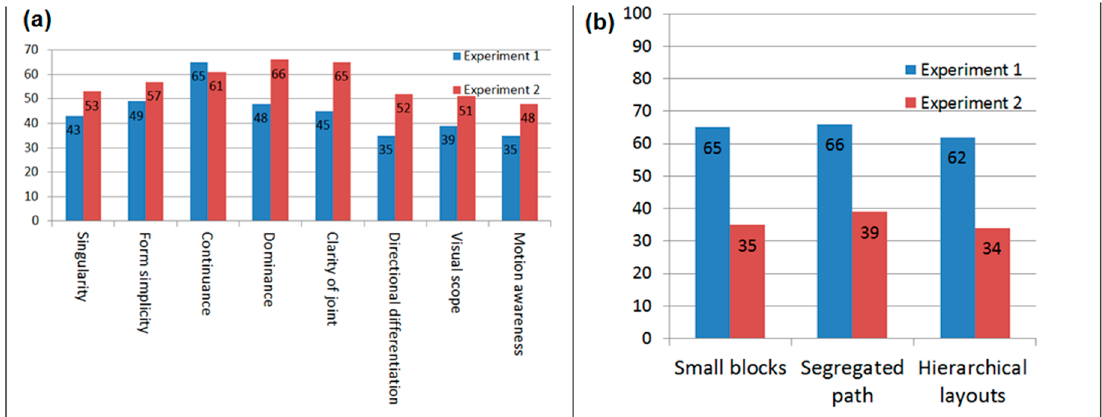
Figure 12. Experiments 1 and 2 outputs compared to the spatial analyses of parameters of ( a ) legibility; and ( b ) permeability (numbers refer to percentages of pixels with less than 10%